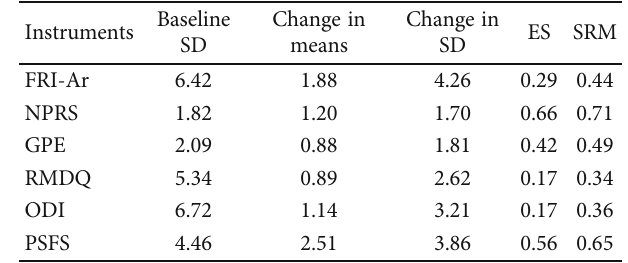
Table 5: Responsiveness of instruments. Table 4: Pearson ’ s correlation among the instruments at baseline.